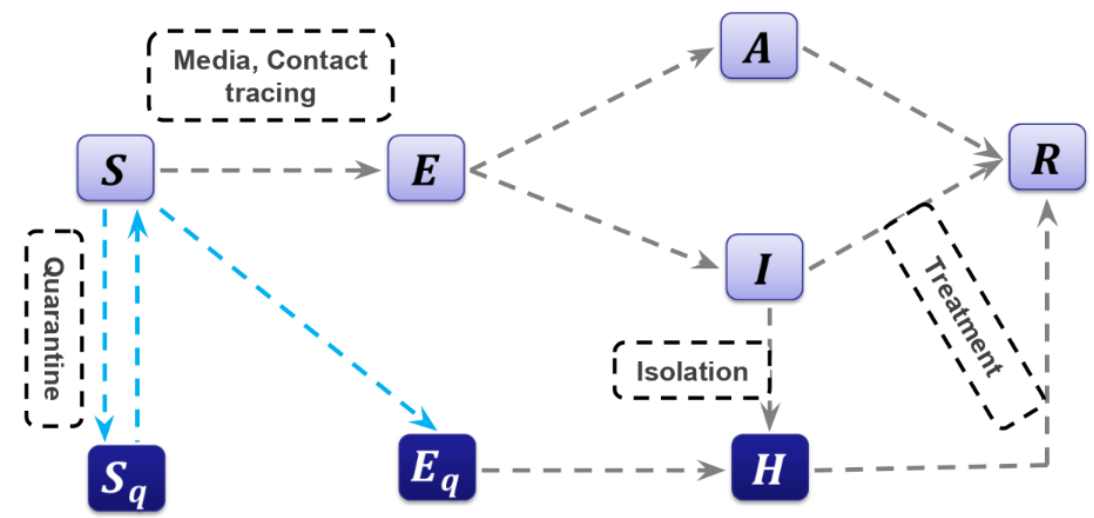
Figure 2. Diagram of the model adopted in the study for simulating the novel coronavirus (2019-nCoV) infection. Interventions including intensive contact tracing followed by quarantine and isolation are indicated.